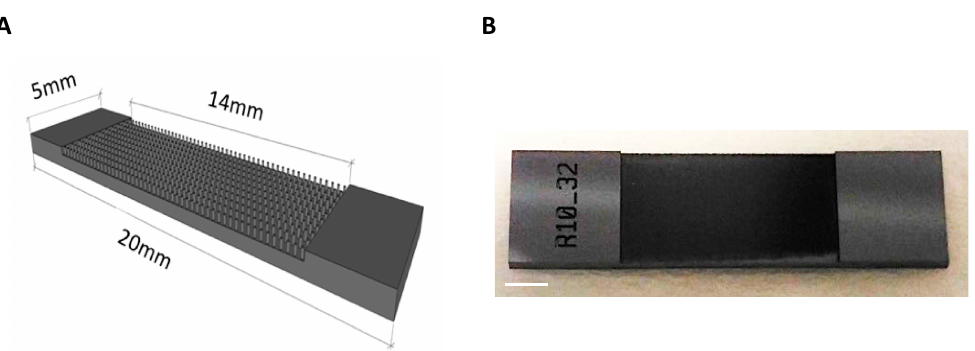
Figure 1. Design, size and morphology of 3D silicon micropillar array slides. ( A ) Schematic structure of a silicon slide containing vertically-aligned micropillars (micropillars are not in scale). ( B ) The image shows a 3D silicon slide. Scale bar: 1 mm.